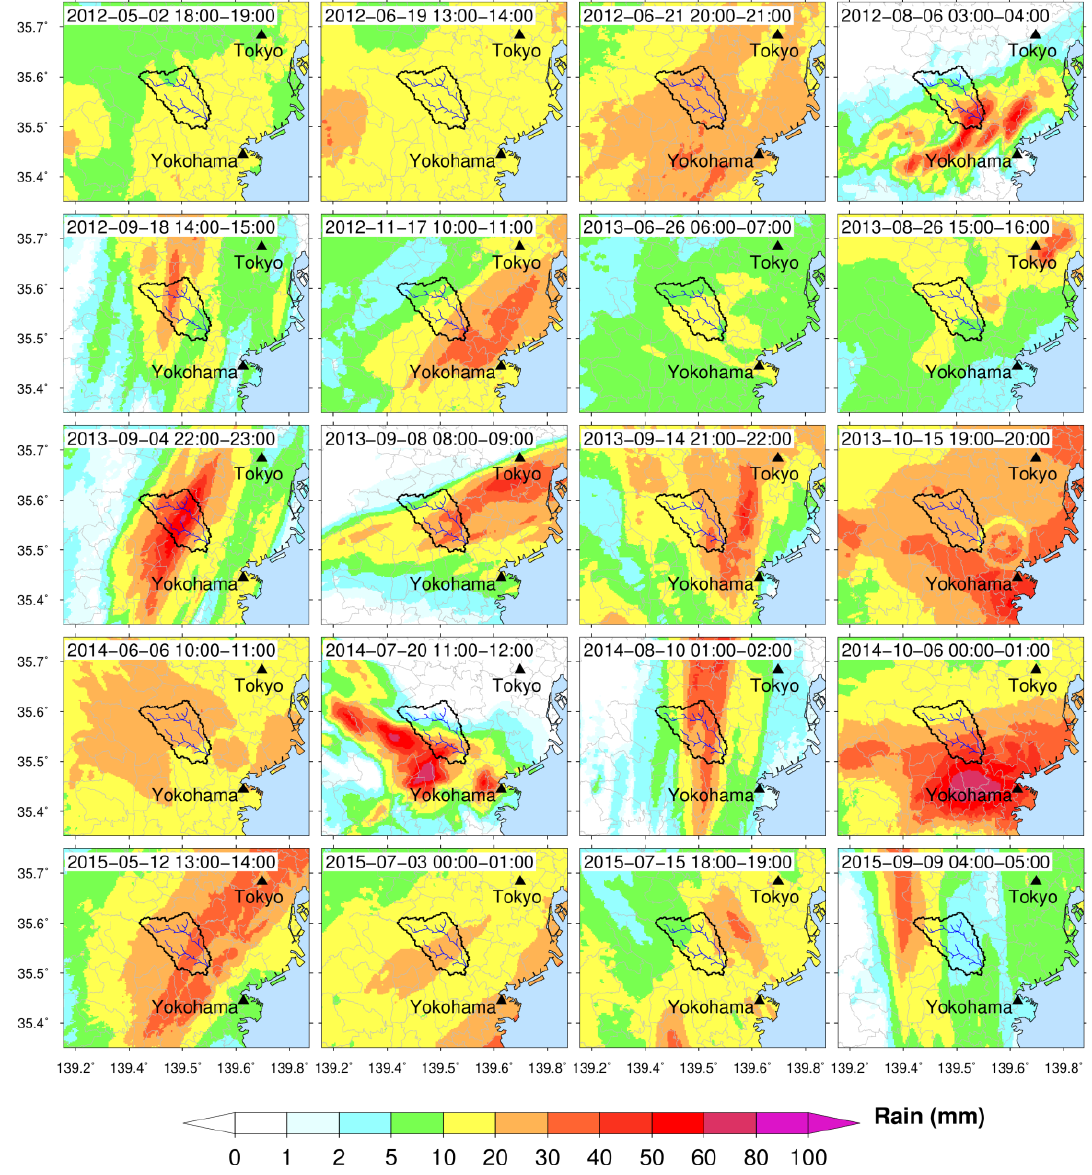
Figure 2. 2-h accumulated rainfall distribution pattern over the Tsurumi River Basin.